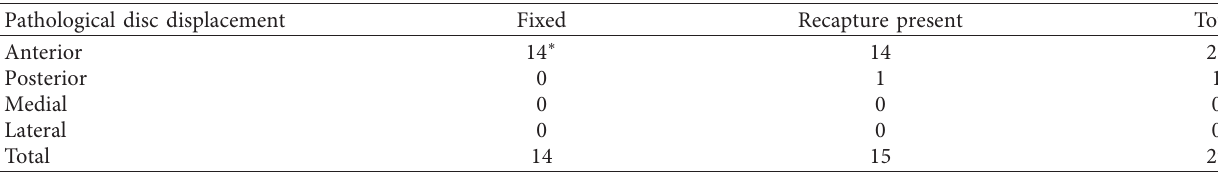
Table 1: A total of 29 of the 61 patients experiencing temporomandibular symptoms had pathology visible on magnetic resonance imaging (MRI), corresponding to a disease prevalence of 47.5%. Pathology is subdivided into anterior, posterior, and medial displacements and summarized here, with the number demonstrating the presence of recapture, osteoarthritic changes, and presence of inflammation (as determined from ultrasound imaging) noted.